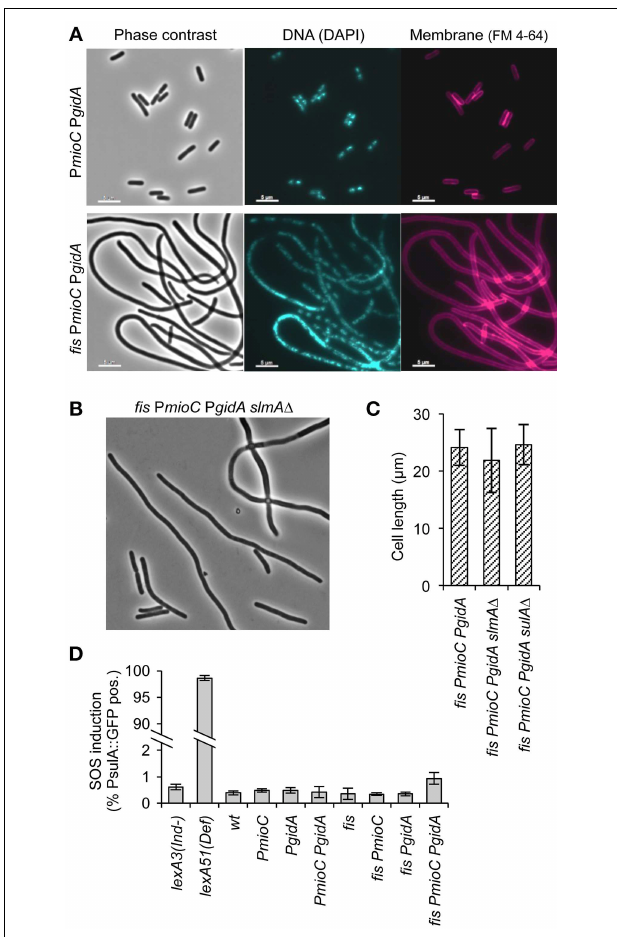
FIGURE 3 | Promoter mutants do not activate the SOS response or nucleoid occlusion. (A) DNA and membrane staining in a PmioC PgidA double mutant (top) or PmioC PgidA fis triple mutant (bottom) indicate an absence of division septa between segregated nucleoids. (B) Phase contrast image of a PmioC PgidA fis slmA 1 quad mutant. (C) Cell length of triple mutant ( PmioC PgidA fis ) cells in the presence or absence of a slmA or sulA deletion mutation. (D) SOS induction in PmioC PgidA and fis mutant combinations was measured by flow cytometry of strains carrying a PsulA::GFP reporter construct (Materials and Methods). Values are means of 3 independent experiments ( ± 1